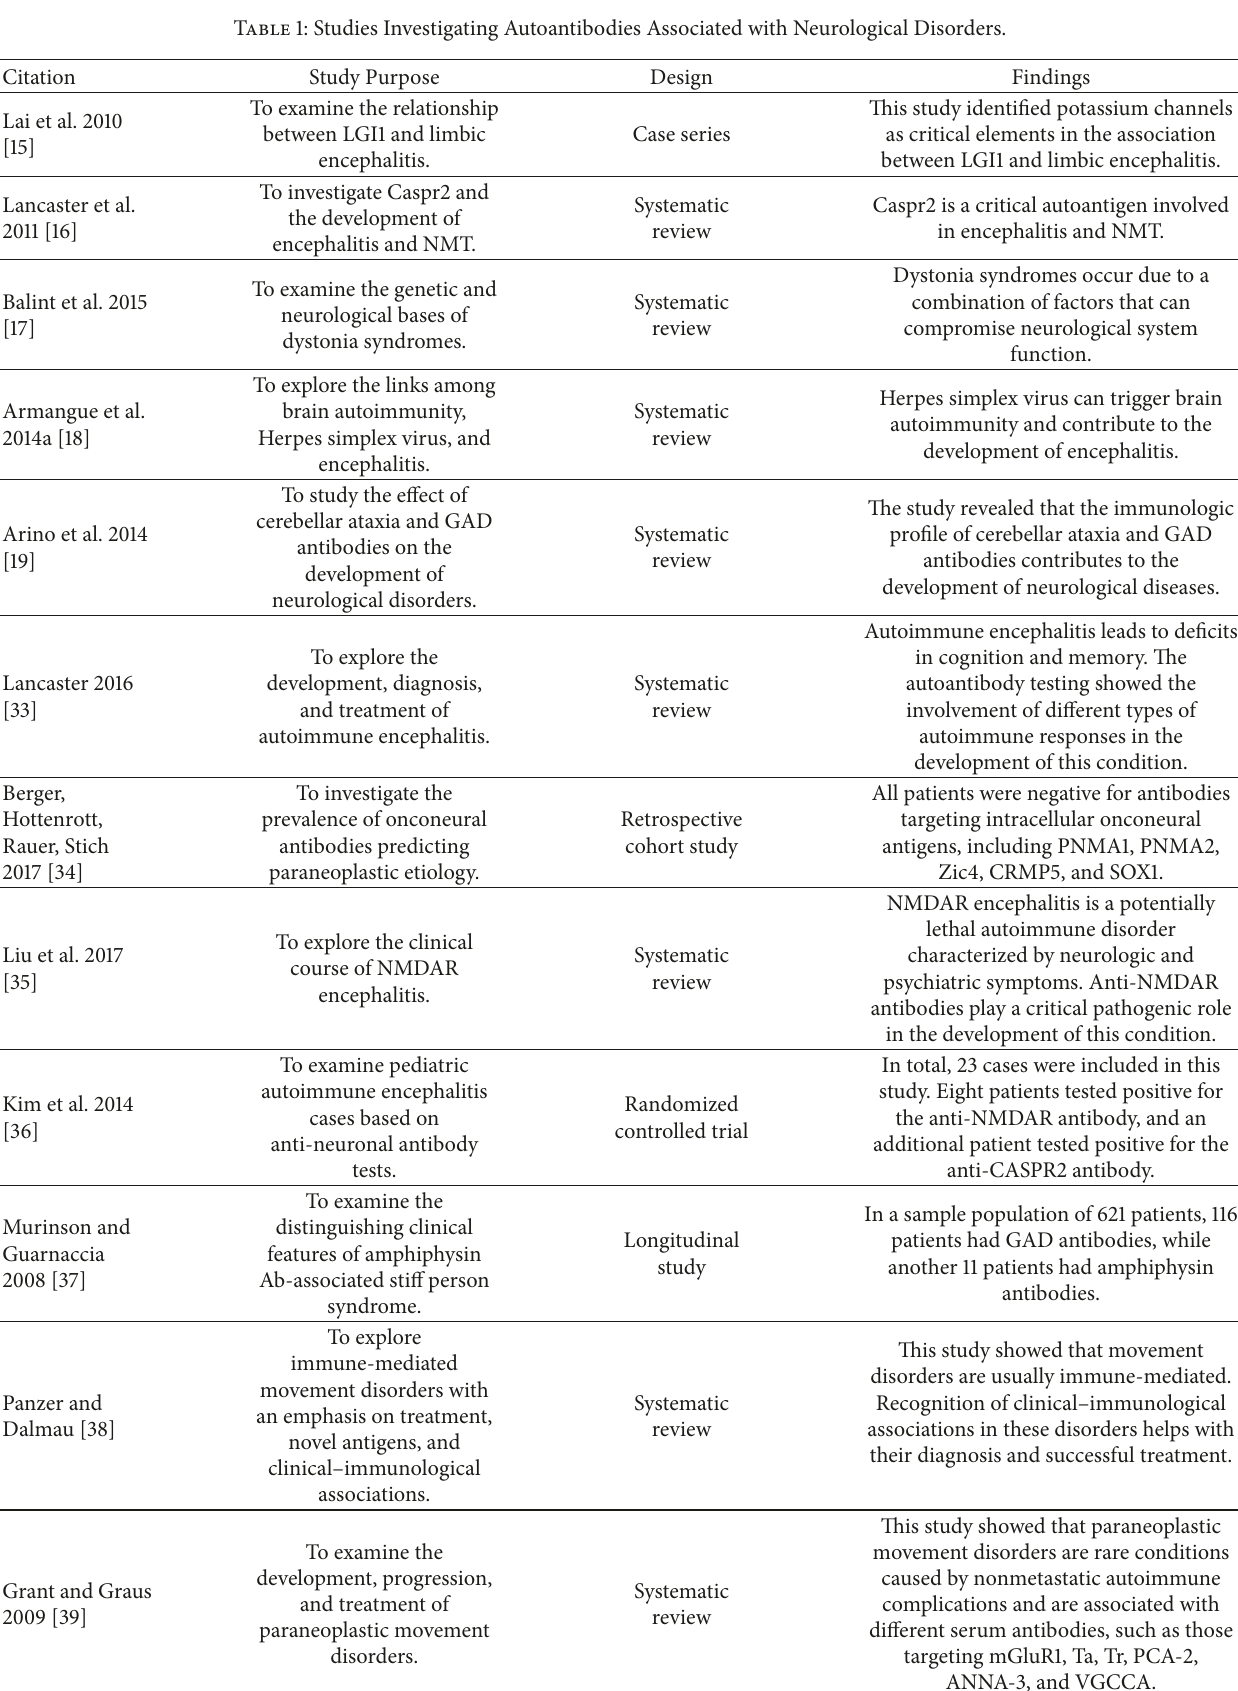
Table 1: Studies Investigating Autoantibodies Associated with Neurological